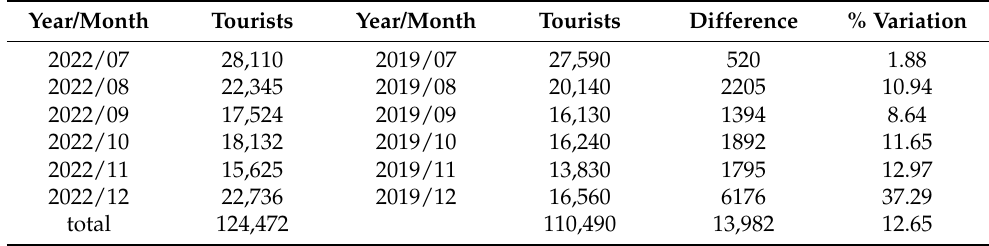
Table 9. Differences in tourist numbers before and after the COVID-19 pandemic in C ó rdoba. Year/Month